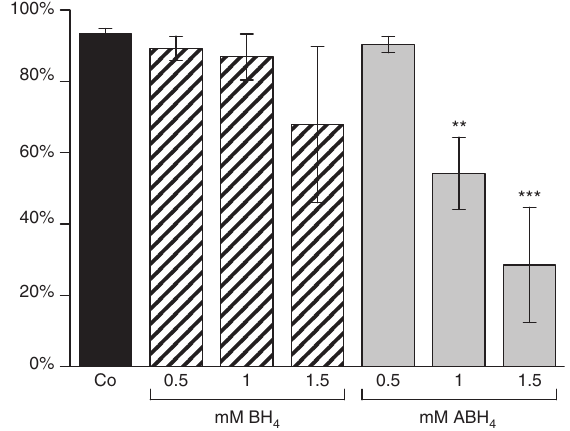
and ABH treatment on cell survival in HL-1 Figure 5 Effects of BH 4 4 cells. HL-1 cells were treated with 0.5, 1, or 1.5 mM of BH or ABH for 4 4 24 h. Cell survival and apoptosis were measured by annexin V/ PI staining. The percentage of viable cells is shown. Data are expressed as mean ± SD (n = 3, **p < 0.01, ***p < 0.001 vs.